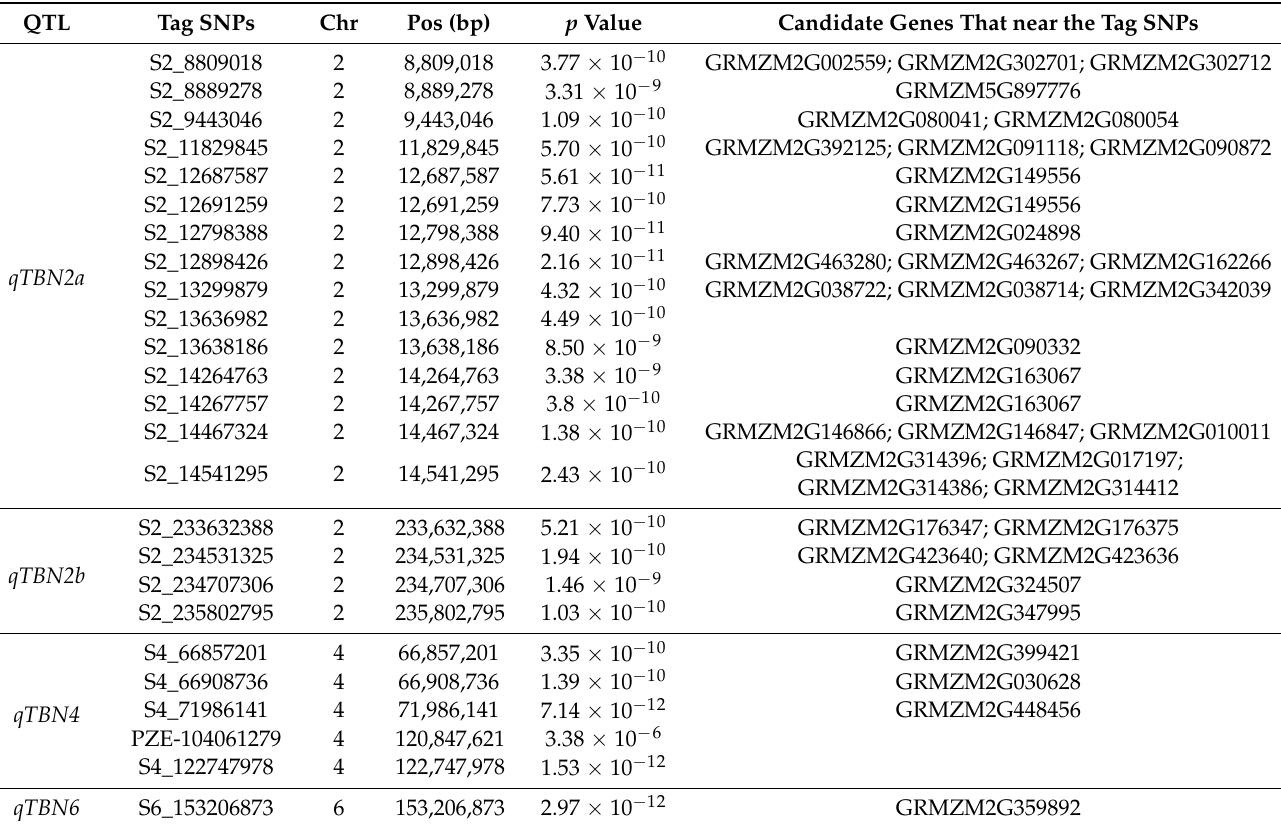
Table 2. List of colocated SNPs and the annotation of candidate